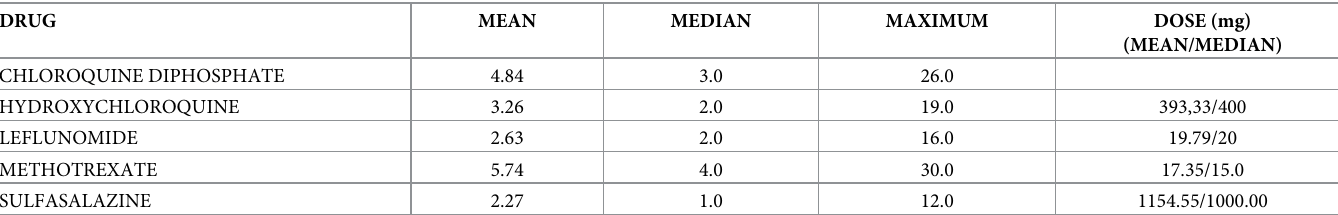
Table 2. Time (in years) of use and doses of synthetic DMARDs in patients with rheumatoid arthritis.